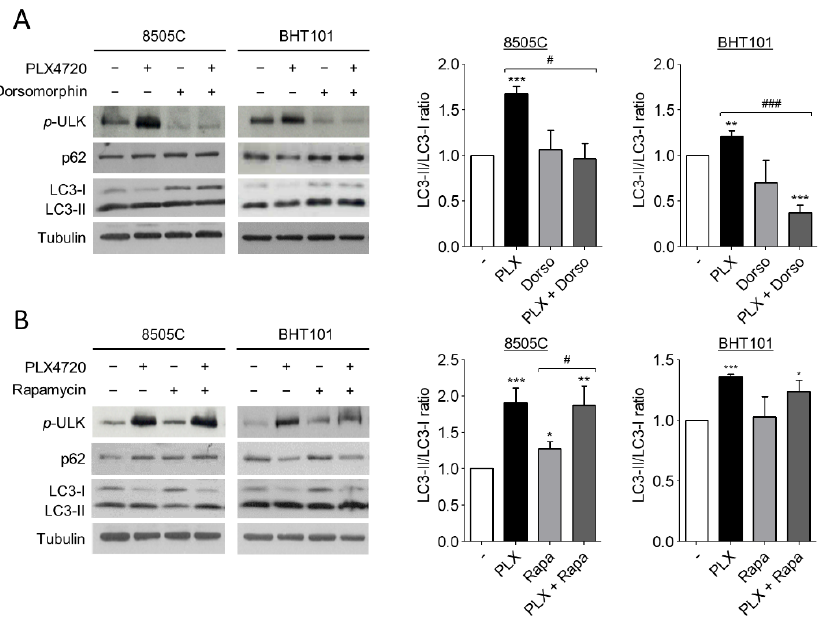
Figure 3. V600E BRAF inhibition increases autophagy through AMPK-ULK1 signalling. Expression levels of phosphorylated ULK1 at Ser555 ( p -ULK), p62 and LC3 (left blots), and quantitative analysis of LC3-II/LC3-I ratios (right graphs) in 8505C and BHT101 cells treated with DMSO (-) or PLX4720 (PLX), in the absence or presence of Dorsomorphin (Dorso) ( A ) or Rapamycin (Rapa) ( B ) for 24 h. For each experiment, membranes were reprobed with anti- β -Tubulin as a loading control. Graphic bars represent the LC3-II/LC3-I ratio, calculated after quantitation of LC3-II and LC3-I bands of the blots, and are presented as fold induction relative to the untreated cells. Blots are from one representative experiment and data shown represent the mean ± SEM of the quantitation of at least three independent experiments performed with similar results. Significant differences compared to the corresponding controls: * 0.01 < p < 0.05, ** 0.001 < p < 0.01, *** p < 0.001, compared to untreated cells; # 0.01 < p < 0.05, ### p < 0.001, compared to Dorsomorphin or Rapamycin, respectively.